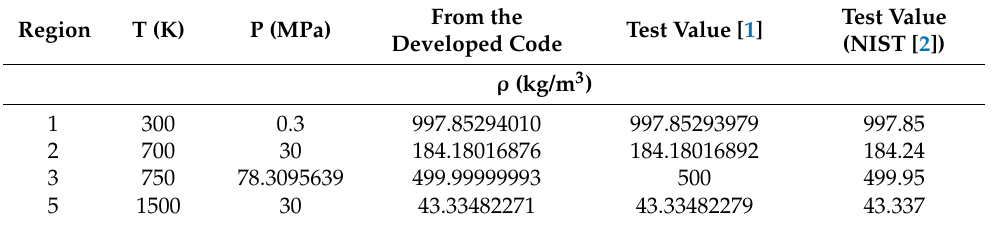
Table 3. Comparison of water properties using IAPWS and the developed program. From